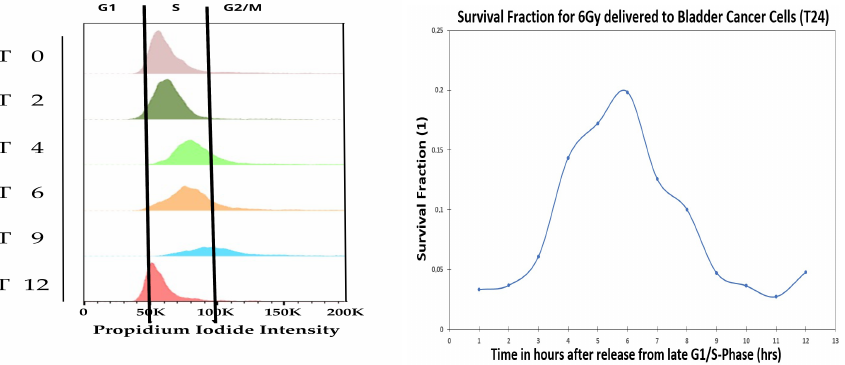
Figure 7. Fluorescence Activated Cell Sorting (FACS) is used to study DNA content during cell cycle using Propidium iodide (PI) at 0 Gy and 21% oxygen pressure. Survival fraction after 6 Gy delivery to the bladder cancer cells, T24, for 1% oxygen